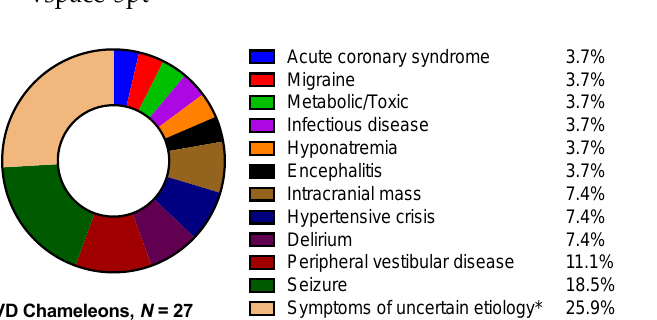
Figure 4. Types of CVD chameleons. * Symptoms of uncertain etiology were purely sensory ( n = 4), unsteadiness ( n = 2), and altered level of consciousness ( n = 1).